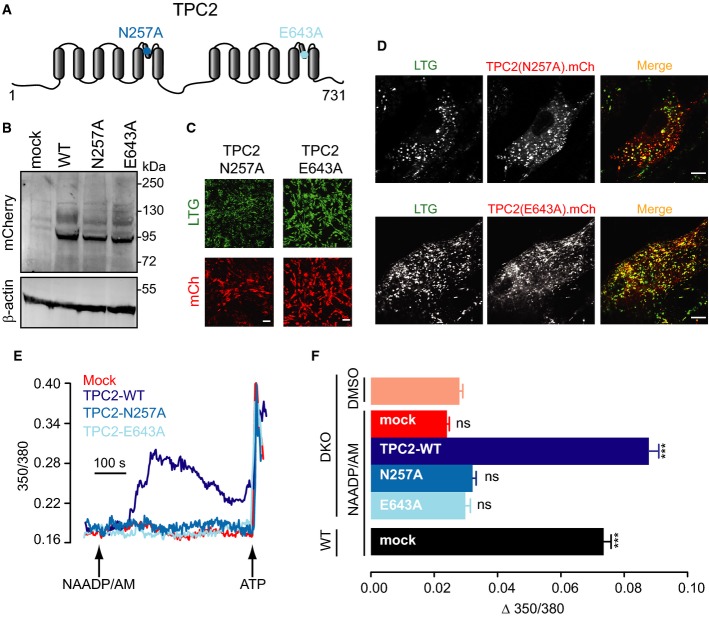
N-terminal truncated forms of TPC1 or TPC2 rescue NAADP-induced Ca2+ release in DKO MEFs

A Schematic representation of TPC1 and TPC2 proteins corresponding to full-length (FL) and N-terminal truncations (ΔN) predicted to be expressed in the mutant Tpcn1/2Dren mice used in Cang et al (2014, 2013) and Wang et al (2012). Transmembrane helices are represented by vertical blocks, and numbers represent amino acid residues.

B Immunoblotting analysis of Tpcn1/2−/− (DKO) MEFs expressing mCherry-tagged mouse TPC1 and TPC2 and full-length (FL) and N-terminal truncations (ΔN). Blot was probed for mCherry and for β-actin as a loading control. Further immunoblots from PNGase F-treated samples are shown in Supplementary Fig S7.

C, D Live-cell imaging of MEF cells expressing mCherry-tagged proteins (LTG, LysoTracker Green signal; mCh, mCherry signal). Scale bar, 100 μm (C; larger images are shown in Supplementary Fig S5) or 10 μm (D). Images in (C) were taken under the same acquisition parameters as in Figs5C and 6C.

E, F Representative fura-2 Ca2+ traces from DKO MEFs expressing mCherry-tagged proteins (mock, empty vector) (E) and maximum Ca2+ responses induced by 10 μM NAADP/AM (F); n = 171–224; ***P < 0.001 relative to mock whereas †††P < 0.001 comparing FL to ΔN using the ANOVA–Tukey test.

G Comparison of number of responding cells to NAADP/AM treatment for each set of transduced DKO MEF cells. Only a cell showing a maximum NAADP/AM-induced Ca2+ response greater than the standard deviation of the basal 350/380 ratio for its set was considered as a responder; ***P < 0.001 relative to mock whereas †††P < 0.001 comparing FL to ΔN using contingency tables.

Data information: Error bars represent SEM. See also Supplementary Fig S5 and Fig S7. Source data are available online for this figure.